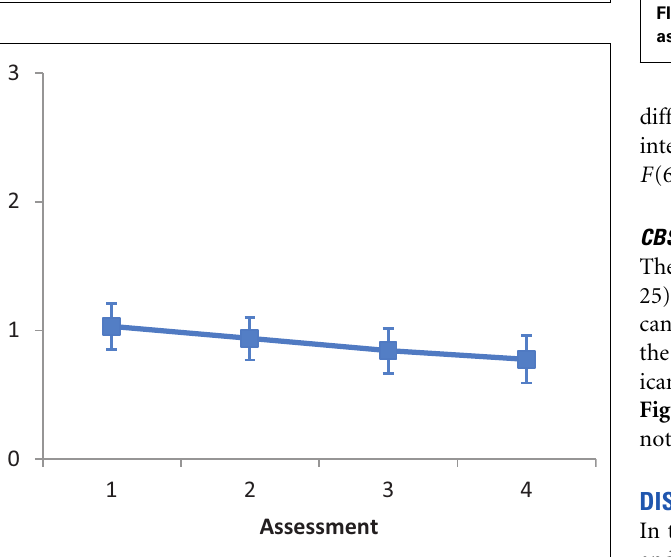
Assessment was significant, F (1.271, 35.583) = 32.947, p < 0.001,